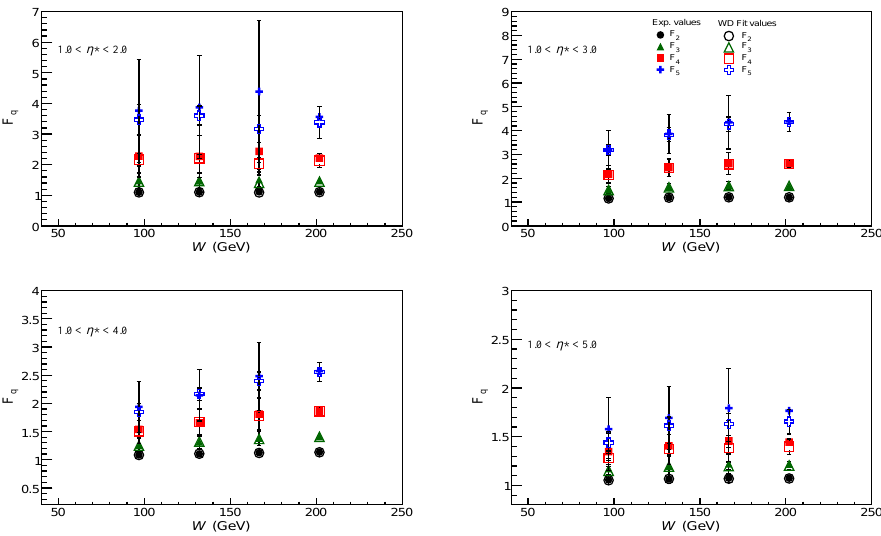
Figure 13. Normalized factorial moments F q for q = 2, 3, 4, 5 for the WD fits and comparison with the values calculated from the data [33] in different η ∗